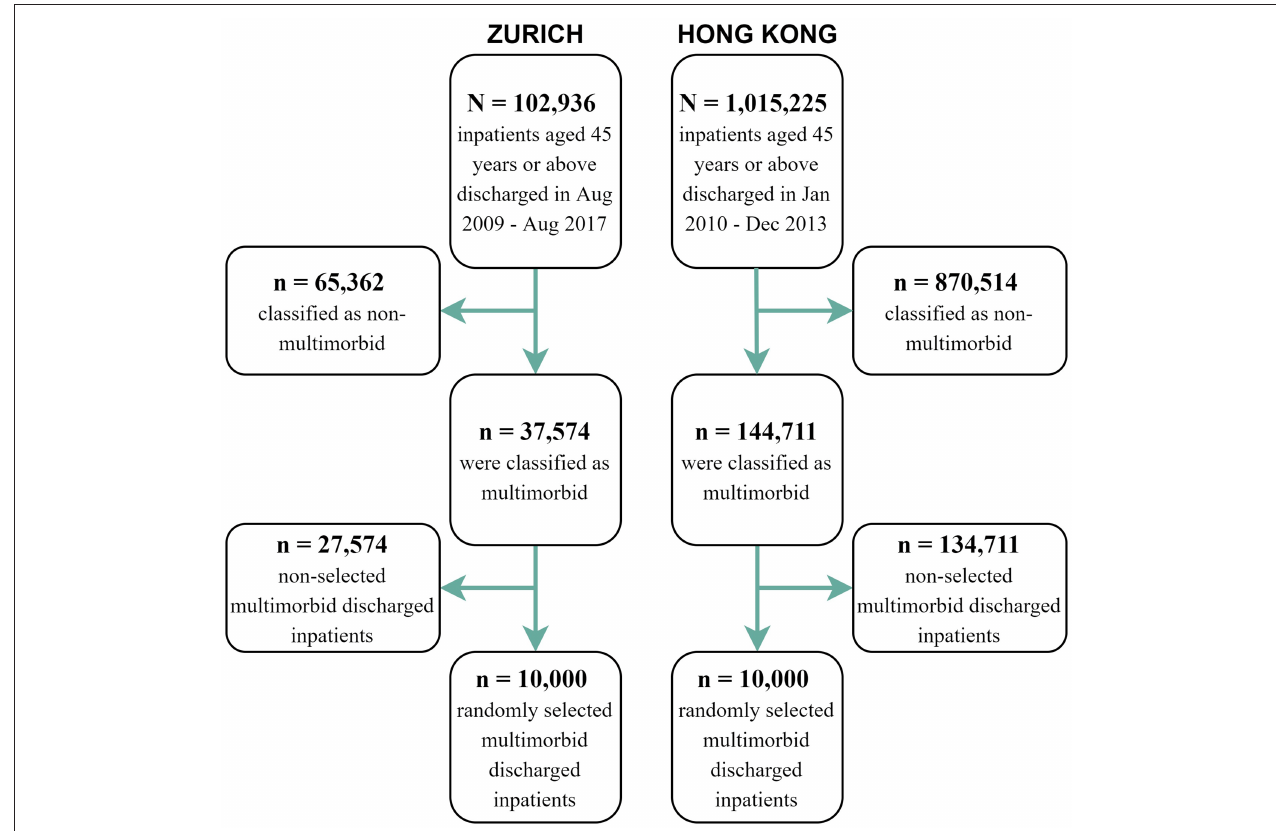
FIGURE 1 | Graphical representation of the sample selection for the analysis.